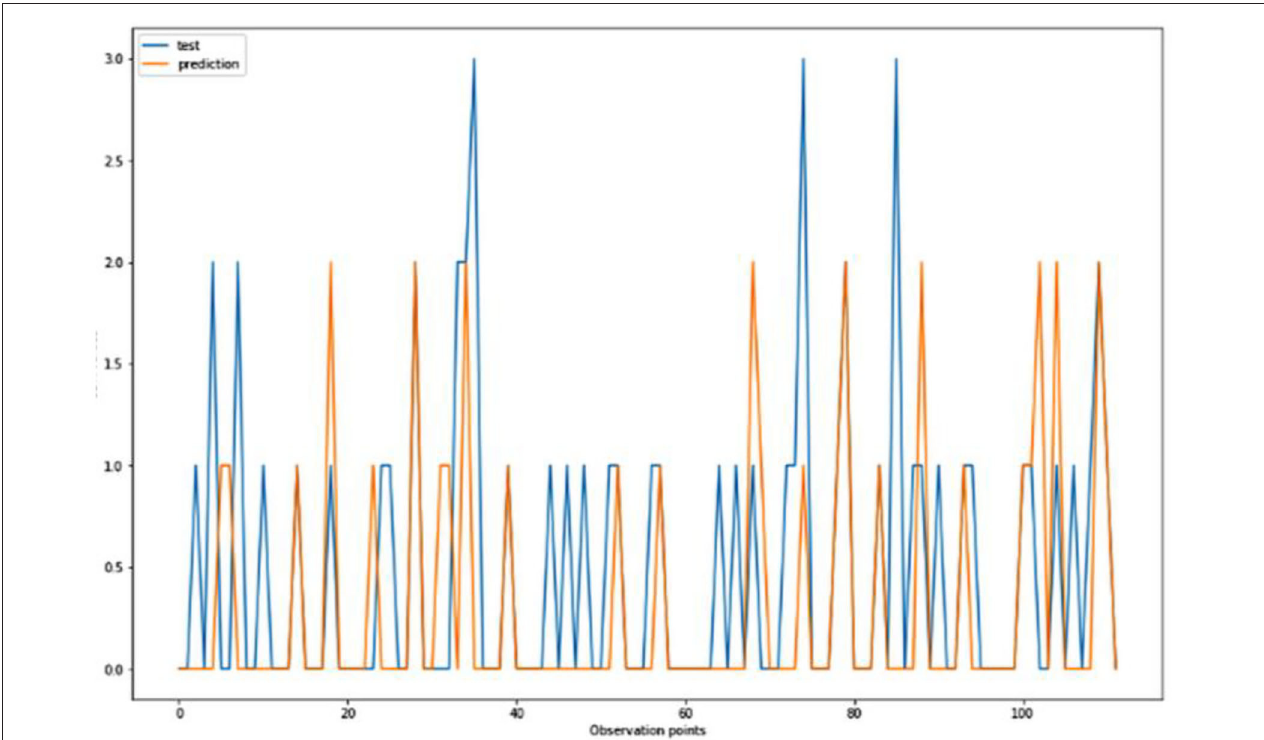
FIGURE 5 | Graphical representation of the comparison of test and predicted CDR values obtained using the k-neighbors classification algorithm. (six parameters).